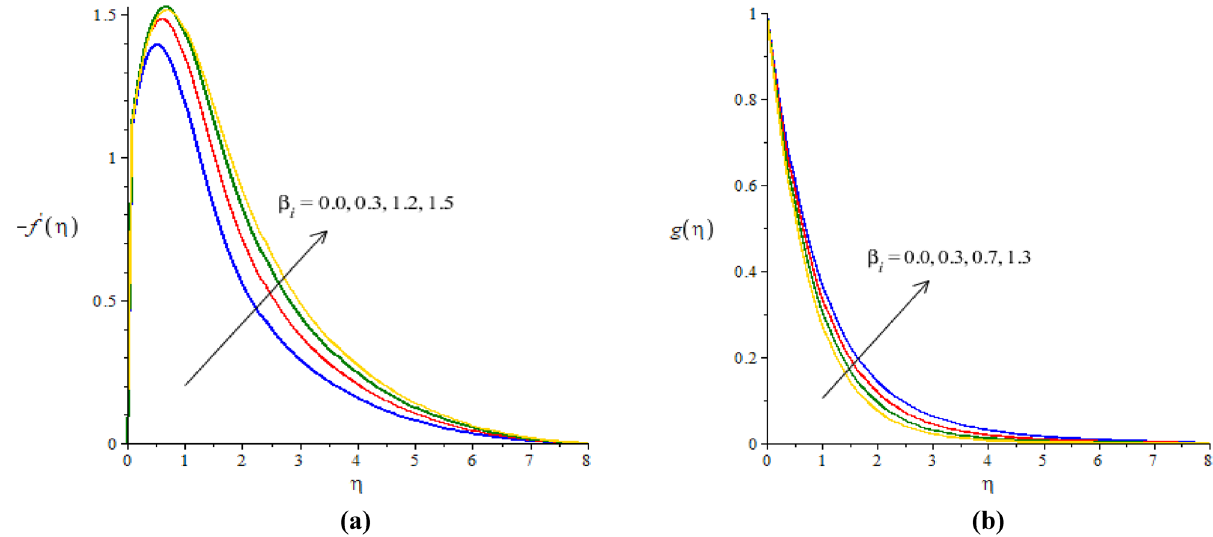
Figure 4. (a,b) The graphical view of velocities versus β i .